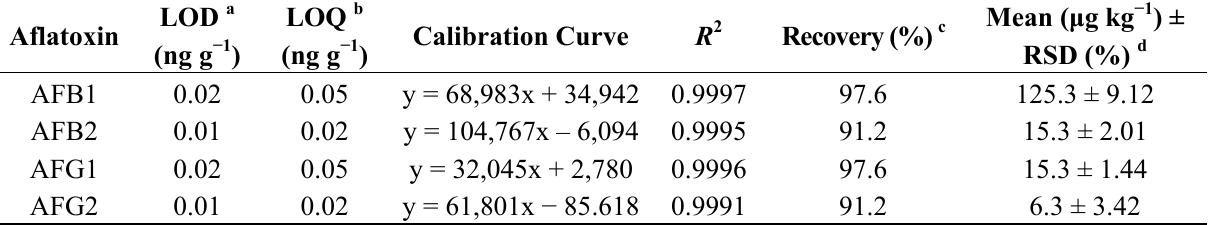
Table 1. Repeatability, reproducibility and accuracy of HPLC method used for aflatoxin determination.